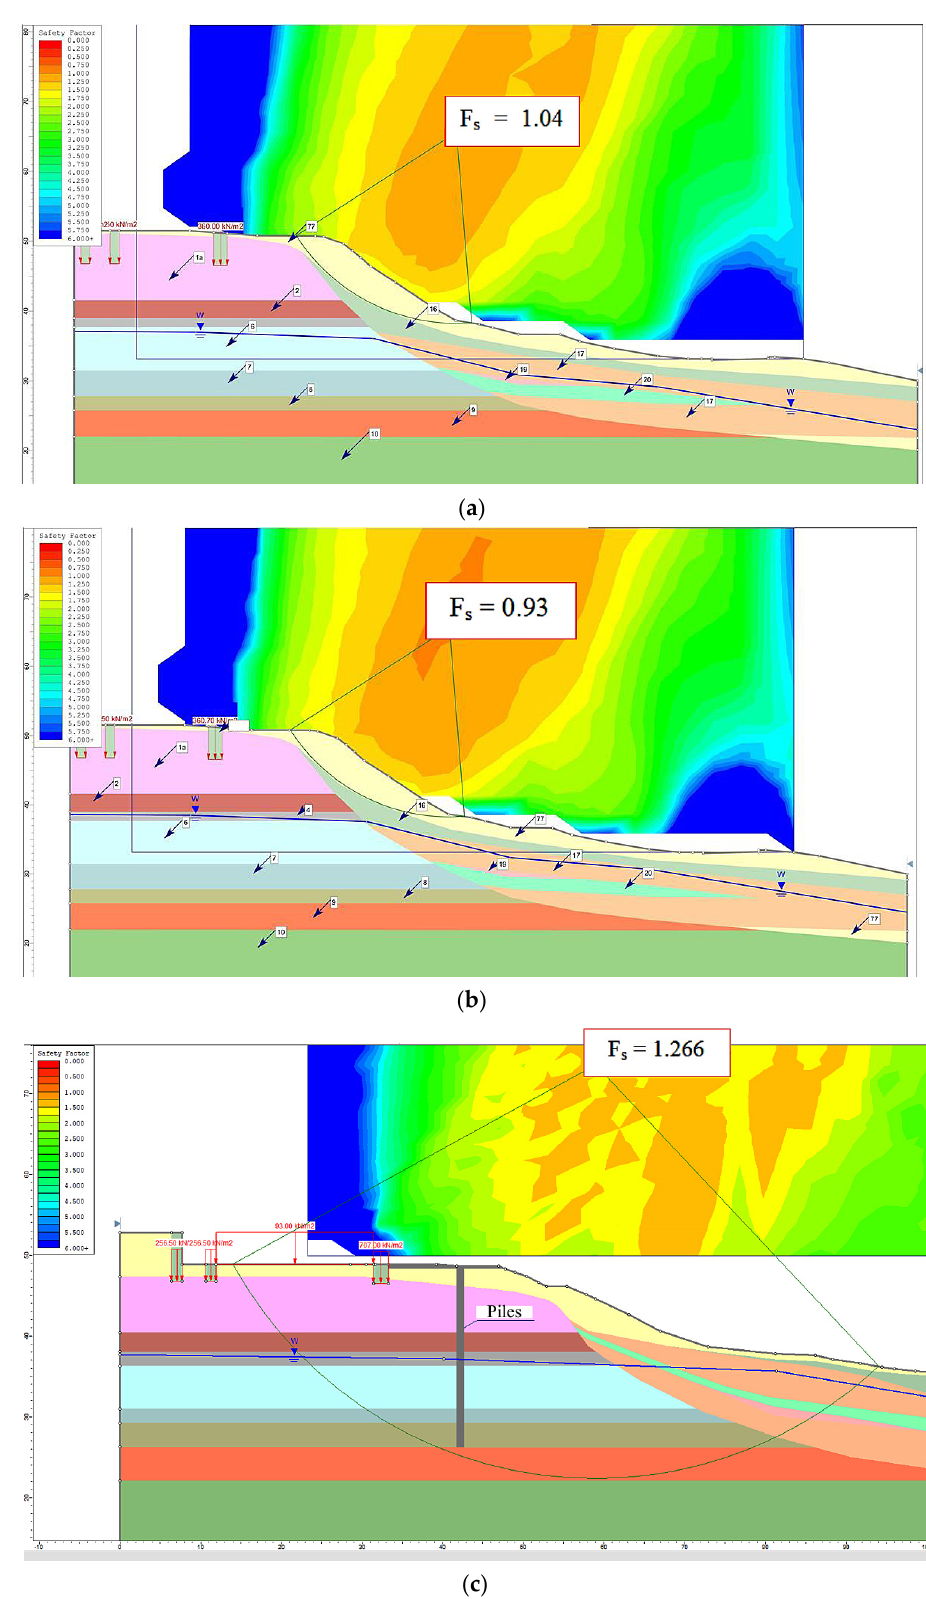
Figure 7. Results of calculation of the landslide hazard slope stability at the “zero” ( a ), “pessimistic” ( b ), and “optimistic” ( c ) scenarios.